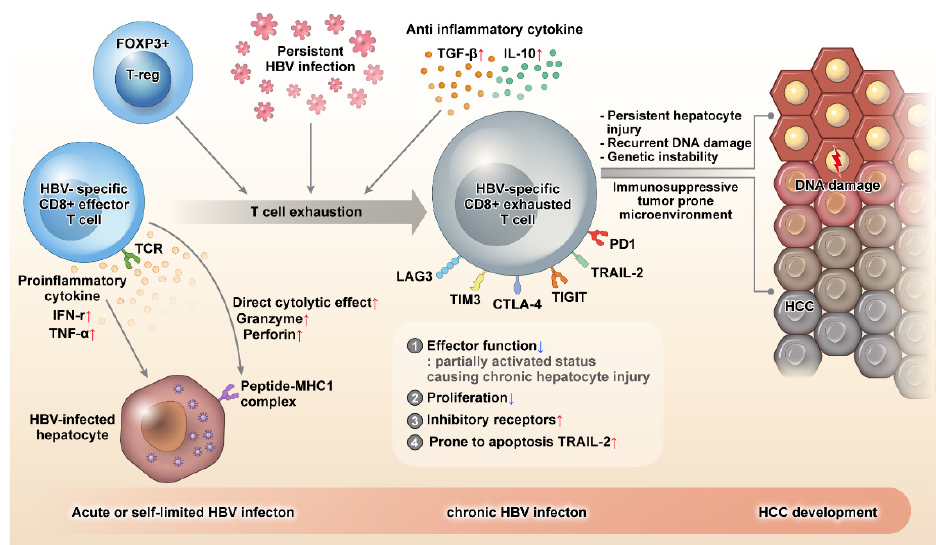
Figure 1. During acute or self-limiting HBV infection, HBV-specific CD8+ effector T cells can control HBV infection effectively by producing pro-inflammatory cytokines, such as IFN- γ and TNF- A , and direct killing of HBV-infected hepatocytes through perforin and granzyme. HBV-specific CD8+ T cells become exhausted in the event of persistent HBV infection. Exhausted CD8+ T cells demonstrate decreased proliferation and are prone to apoptosis by the upregulation of the death receptor